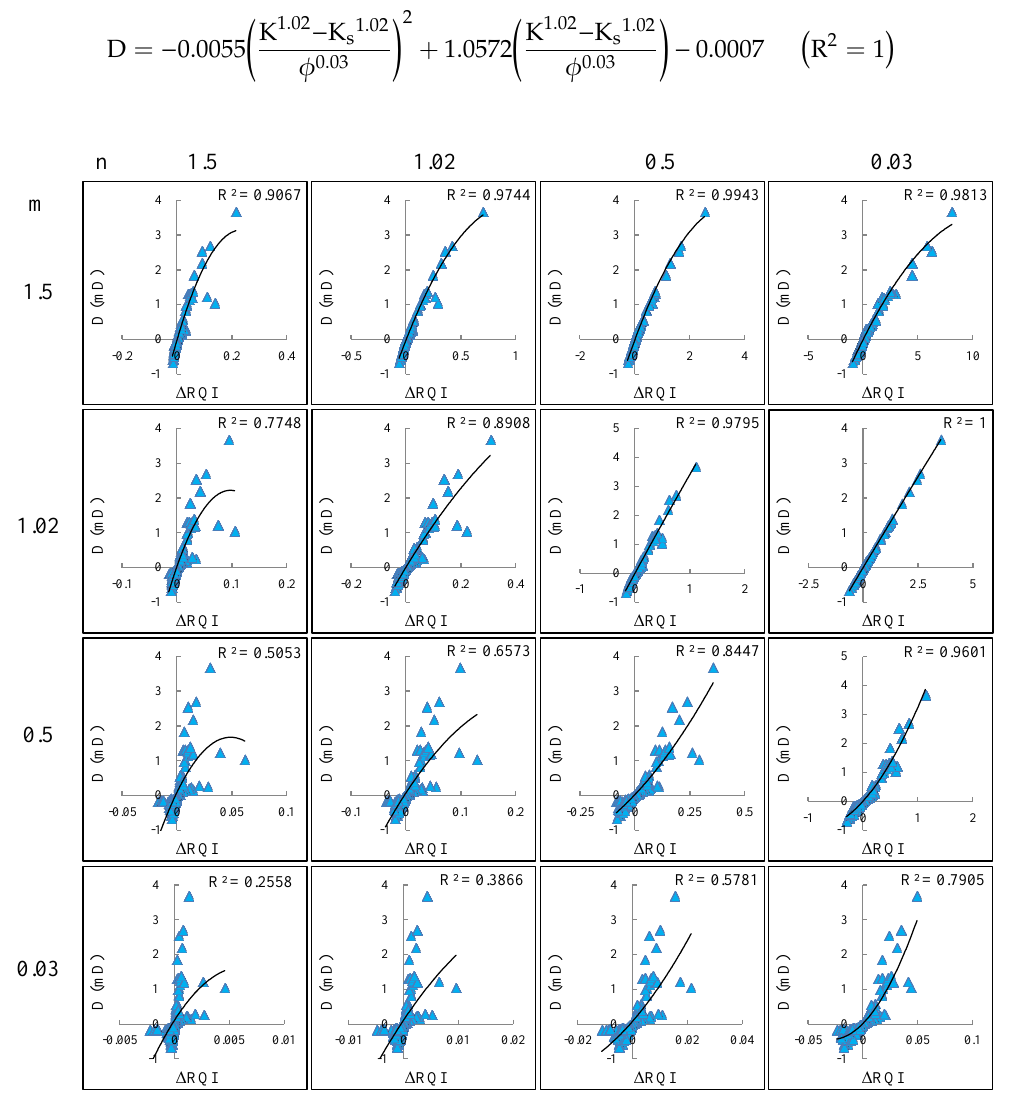
Figure 4. The partial statistical results of the correlation between the D value and the ΔRQI (reservoir quality index), as the m and n values change.